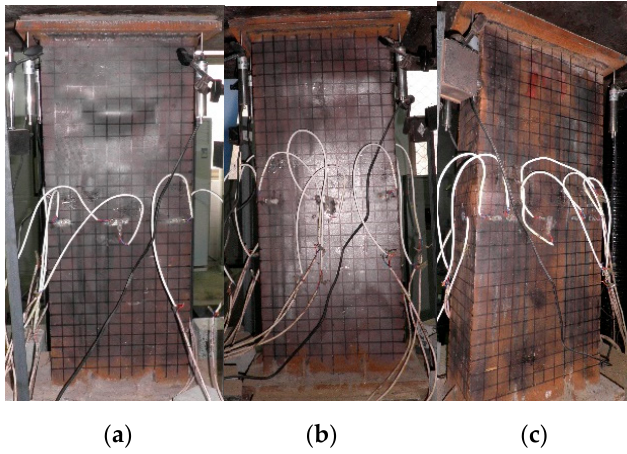
Figure 3. Failure modes of typical specimens. ( a ) A-60-CF70 / 1.2; ( b ) B-0-CF80 / 1.2; ( c ) C-0-CF80 /